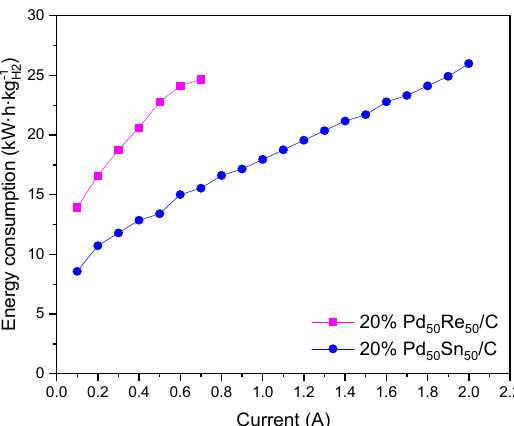
Figure 6. Energy requirements to produce 1 kg of hydrogen at different applied currents.